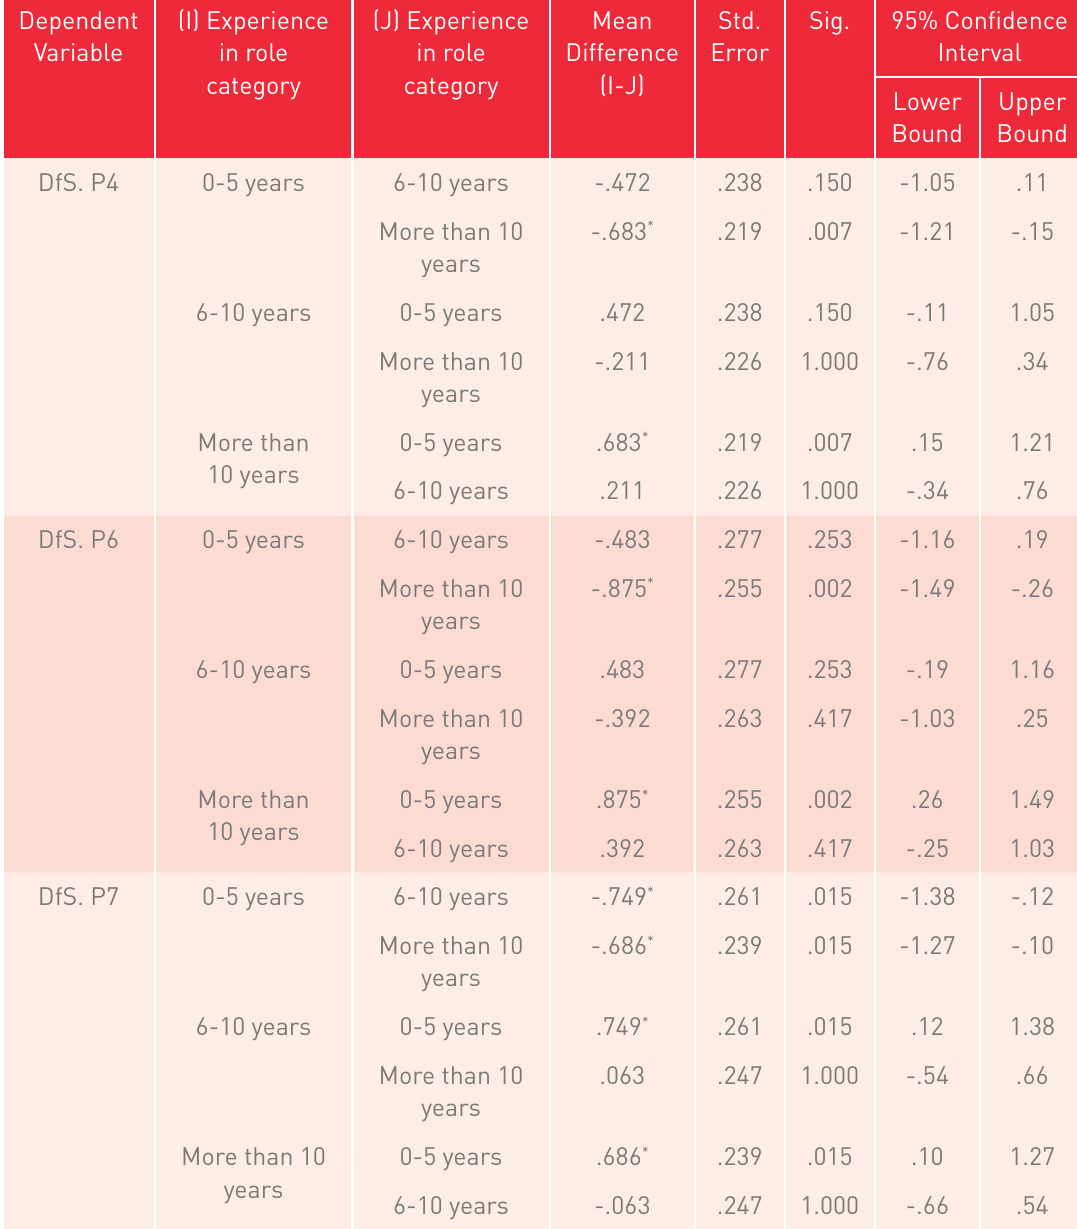
Table 13. ANOVA Post Hoc Test (Multiple Comparisons Bonferroni)